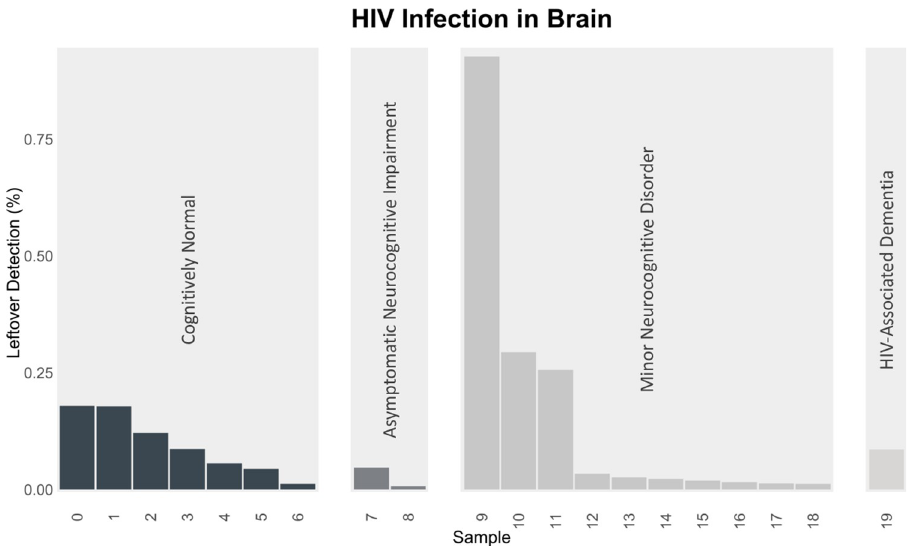
Fig 5. HIV detection behind the blood-brain barrier. Percentage of unmappable human reads that mapped to HIV from those who were deemed cognitively normal (CN), asymptomatic (ANI), minor disorder (MND), or dementia